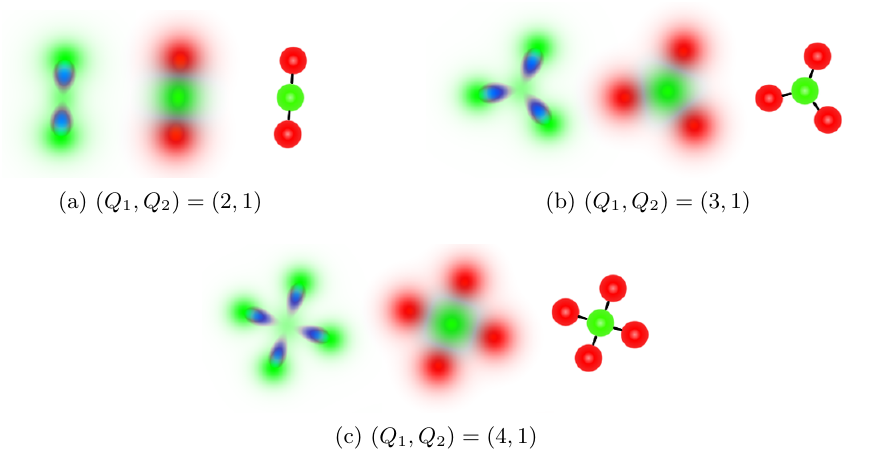
Figure 5 : ( Q 1 ; Q 2 ) = ( Q; 1) minimal vortex \(cid:13)owers", with Q = 2 ; 3 ; 4. Each sub(cid:12)gure contains 3 elements from left to right: an energy density plot, a (cid:12)eld density plot and a sketch of how the red and green vortices are interconnected. The (cid:12)rst two plots are made using the coloring scheme of (cid:12)gure